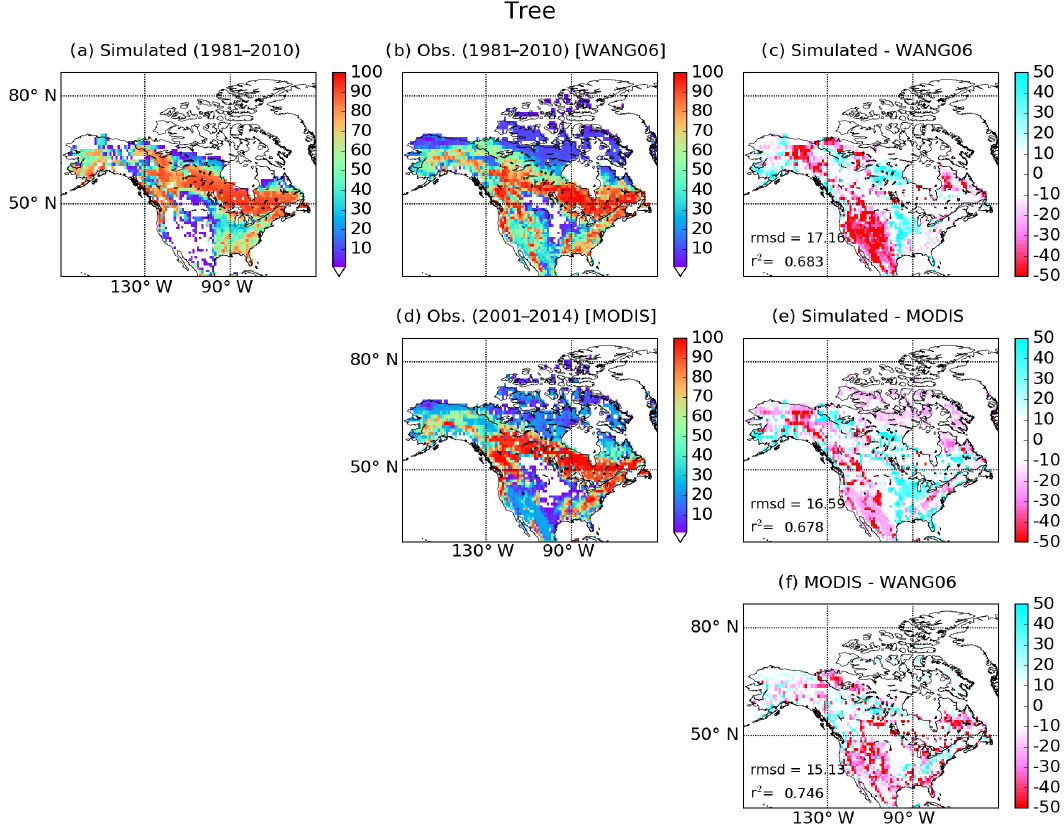
Figure 5. Spatial distribution of tree coverage across North America. Model-simulated results are shown in the left column (a) and the two observation-based estimates are shown in the middle column (b, d) . The right column (c, e, f) shows the difference between model- and observation-based estimates (simulated minus WANG06 in c , and simulated minus MODIS in e ), and the observation-based estimates themselves (MODIS minus WANG06 in f ) along with the root mean square difference (rmsd) and spatial correlation ( R 2 ) between the two estimates being